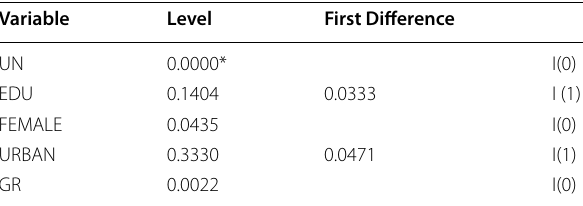
Table 2 Unit root test Table 3 ARDL bootstrap cointegration